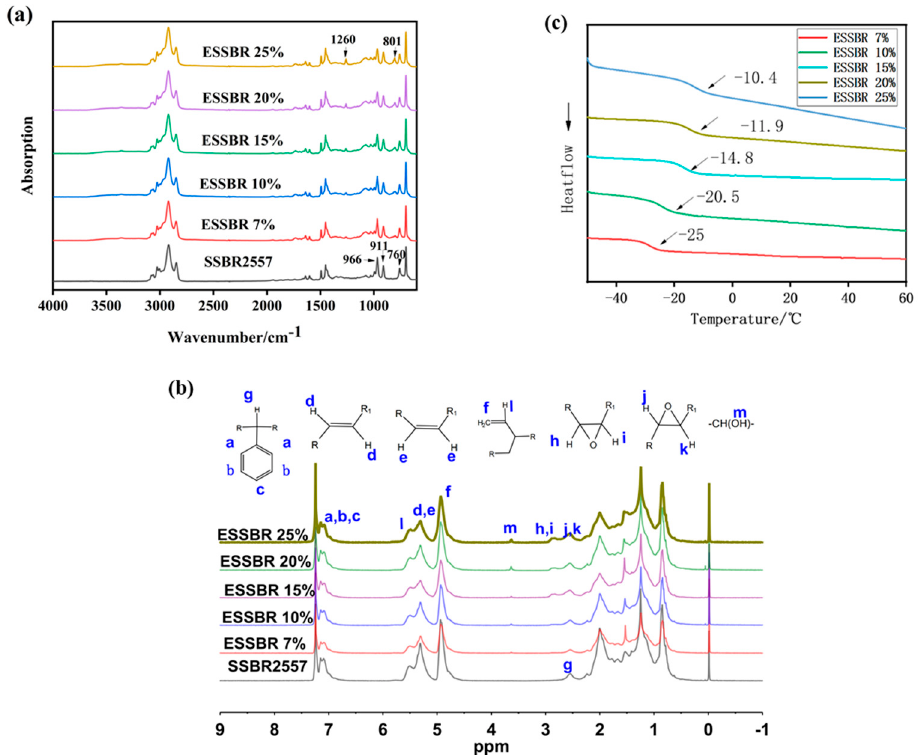
Figure 3. Structure characterization of SSBR and epoxidized solution polymerized styrene-butadiene rubbers ESSBRs: ( a ) FT-IR spectra ( b ) 1 H NMR spectra and ( c ) DSC.